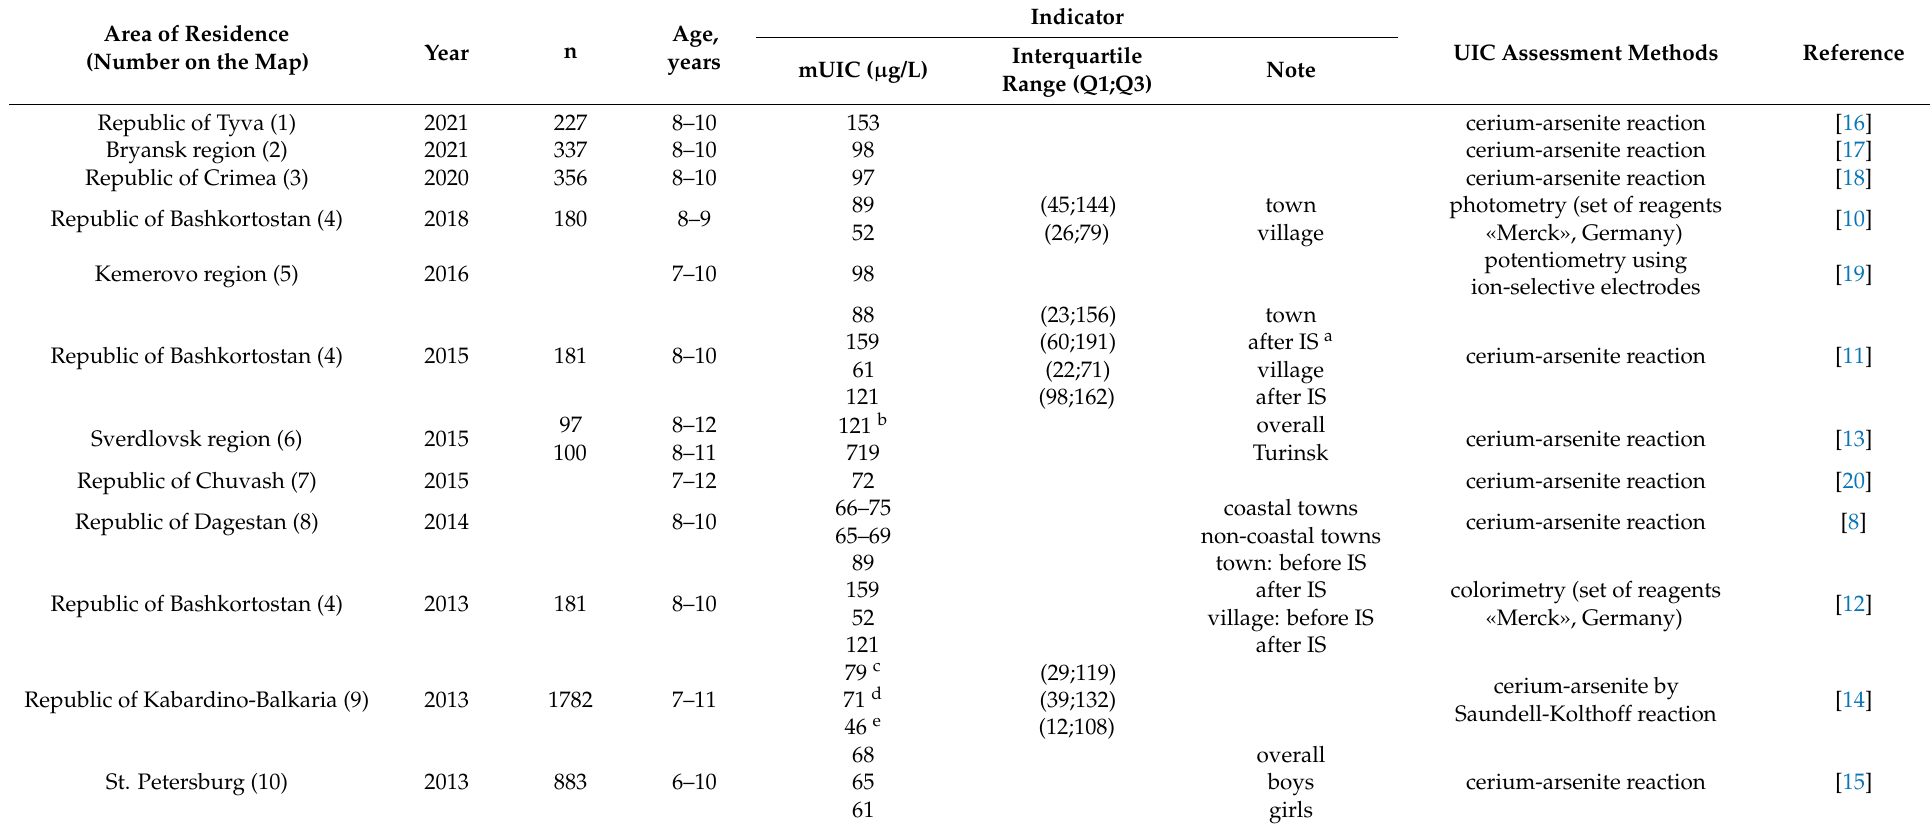
Table 1. Summary of research papers presenting urinary iodine concentration (UIC) among 6–12-year-old children in Russia published in